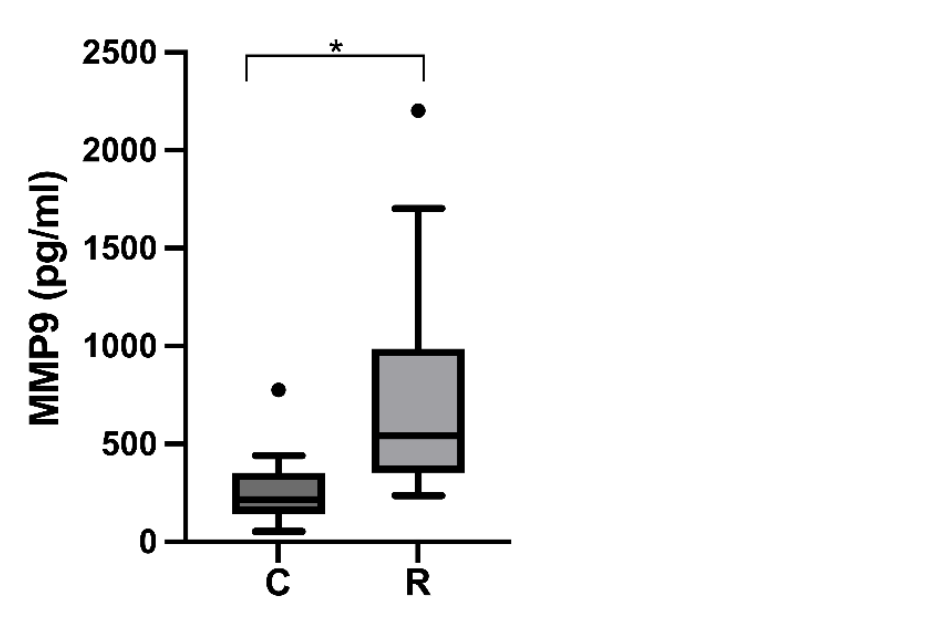
Figure 1. MMP-9 levels in the gingival crevicular fluid in rosacea patients and controls. Higher levels of mmp-9 were observed in the GCF of rosacea patients compared to controls, * p < 0.0001. C: control, R: rosacea. Black dot = outlier.